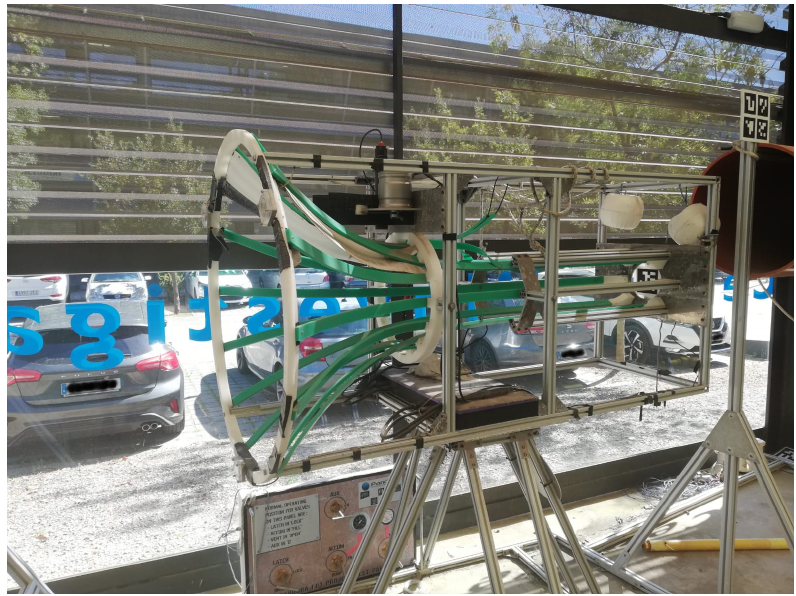
Figure 12. Photography of the docking station.